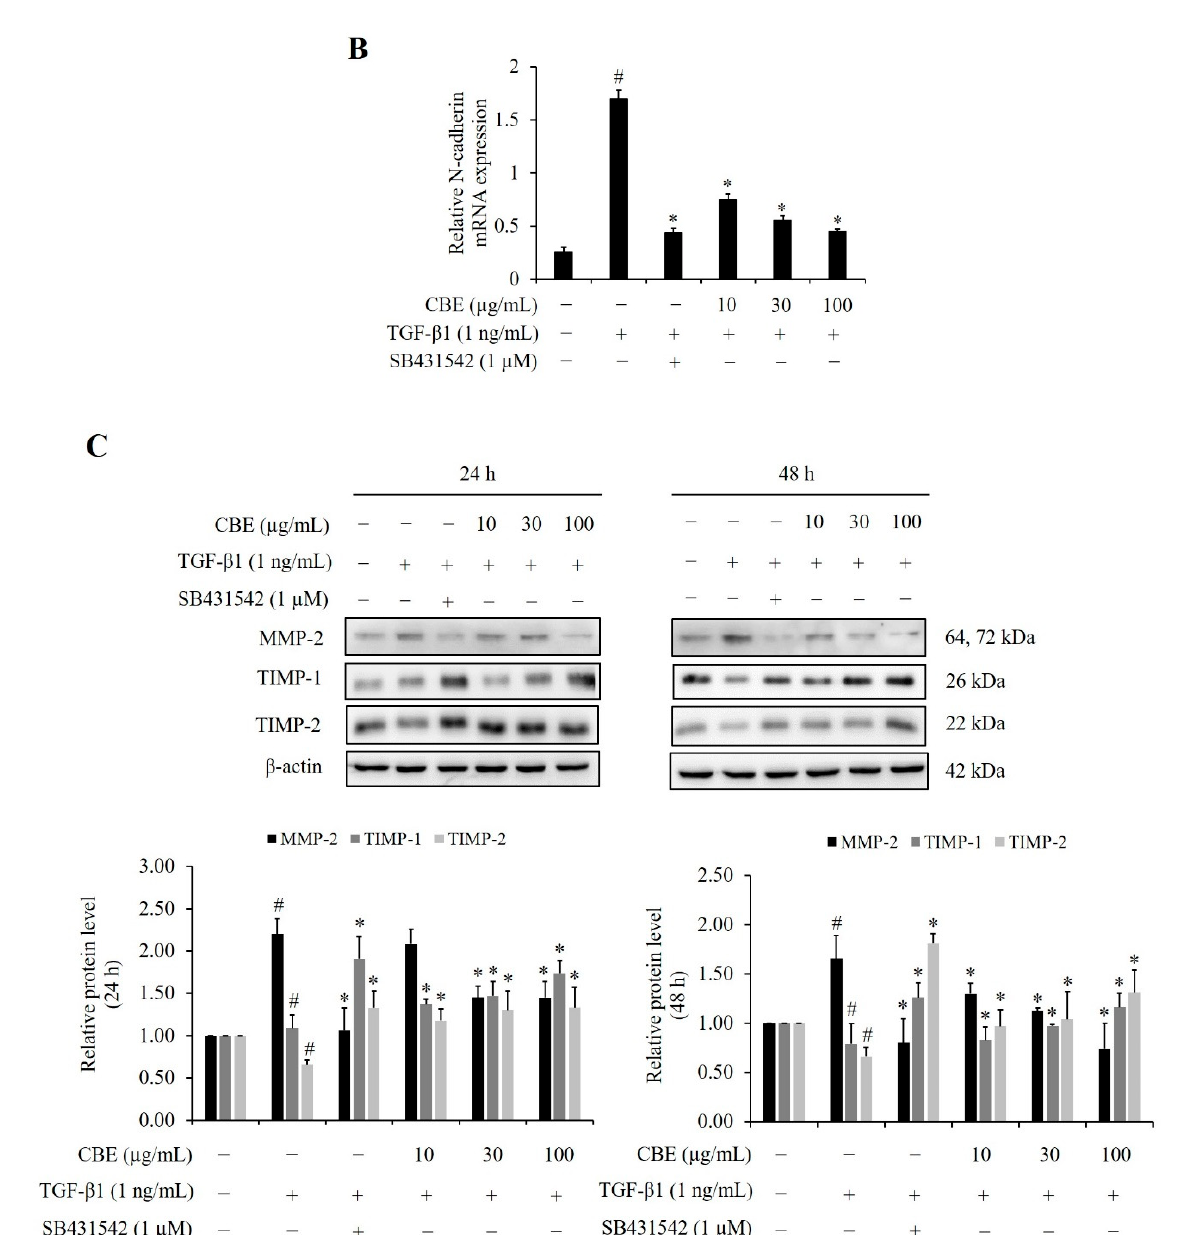
Figure 4. Effect of CBE on TGF- β 1-induced EMT-related biomarker proteins expression. Cells were pre-treated with CBE and SB431542 then stimulated with TGF- β 1 for an additional 24 and 48 h. ( A ) Western blotting analysis of E-cadherin and N-cadherin EMT marker protein. ( B ) qPCR analysis of N-cadherin mRNA expression. ( C ) Western blotting analysis of MMP-2, TIMP-1, and TIMP-2. β -actin was used as an internal control. The amount of N-cadherin mRNA was normalized using RPL37A mRNA as a reference. Results are presented as mean values ± SD ( n = 3). # p < 0.05 versus the control group. * p < 0.05 versus the TGF- β 1 treated group. CBE, Cinnamomum bejolghota